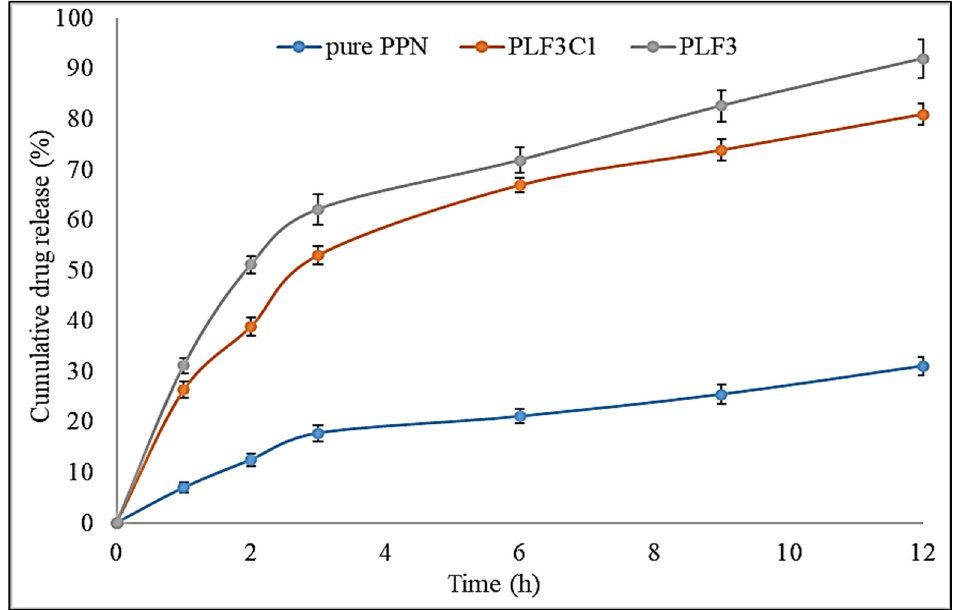
Figure 4. Comparative drug release study profile of pure PPN, PPN liposomes (PLF3) and chitosan-coated PPN liposomes (PLF3C1). The study was performed in triplicate and data are shown as mean ± SD.